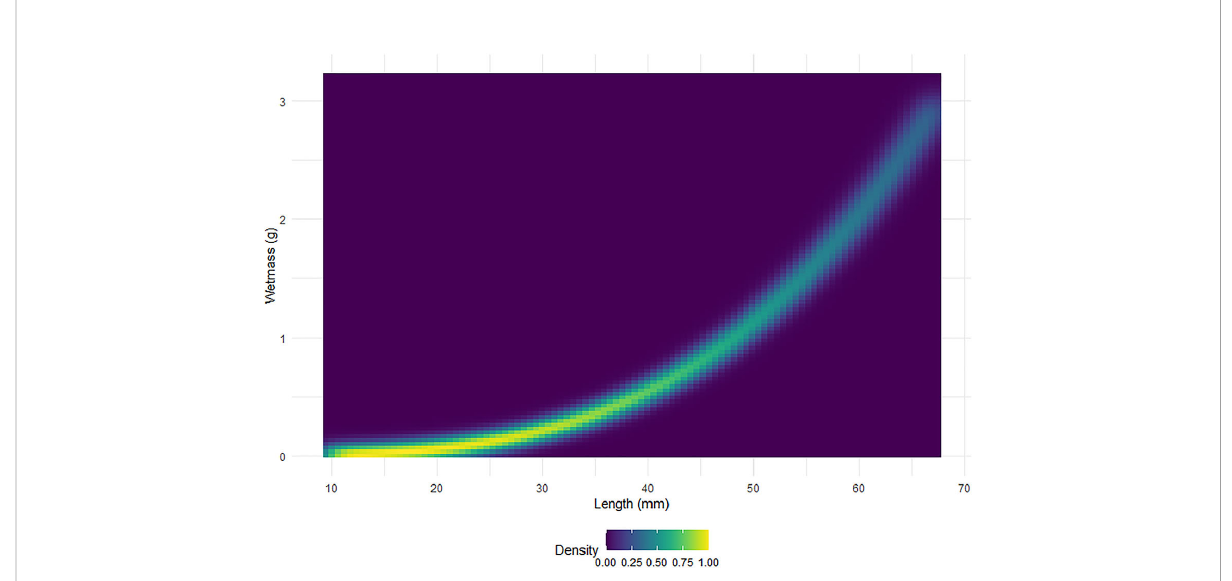
FIGURE 7 A heatmap of the standardised relative density, scaled to one, of krill wetmass as a function of length. A total of 999 simulations of wetmass are